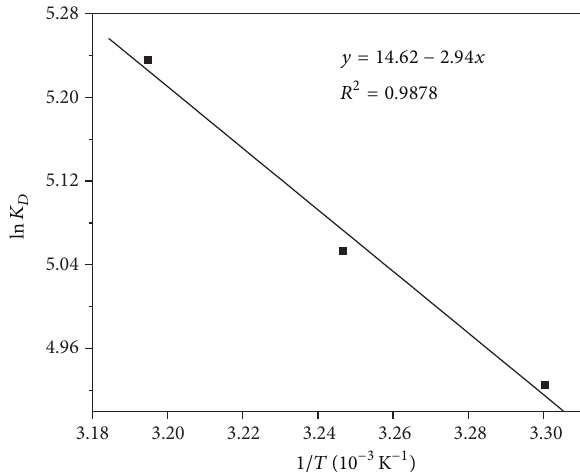
Figure 4: Effect of initial pH on ammoniacal nitrogen adsorption on X/AC composite at 298 K.